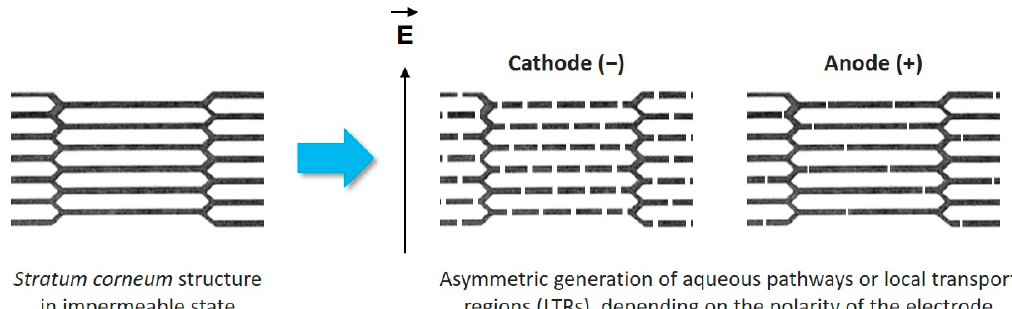
Figure 7. LTRs are generated differently depending on the electrode polarity upon application of EP treatment. They might be more numerous and/or wider at the cathode side. Adapted from [11].